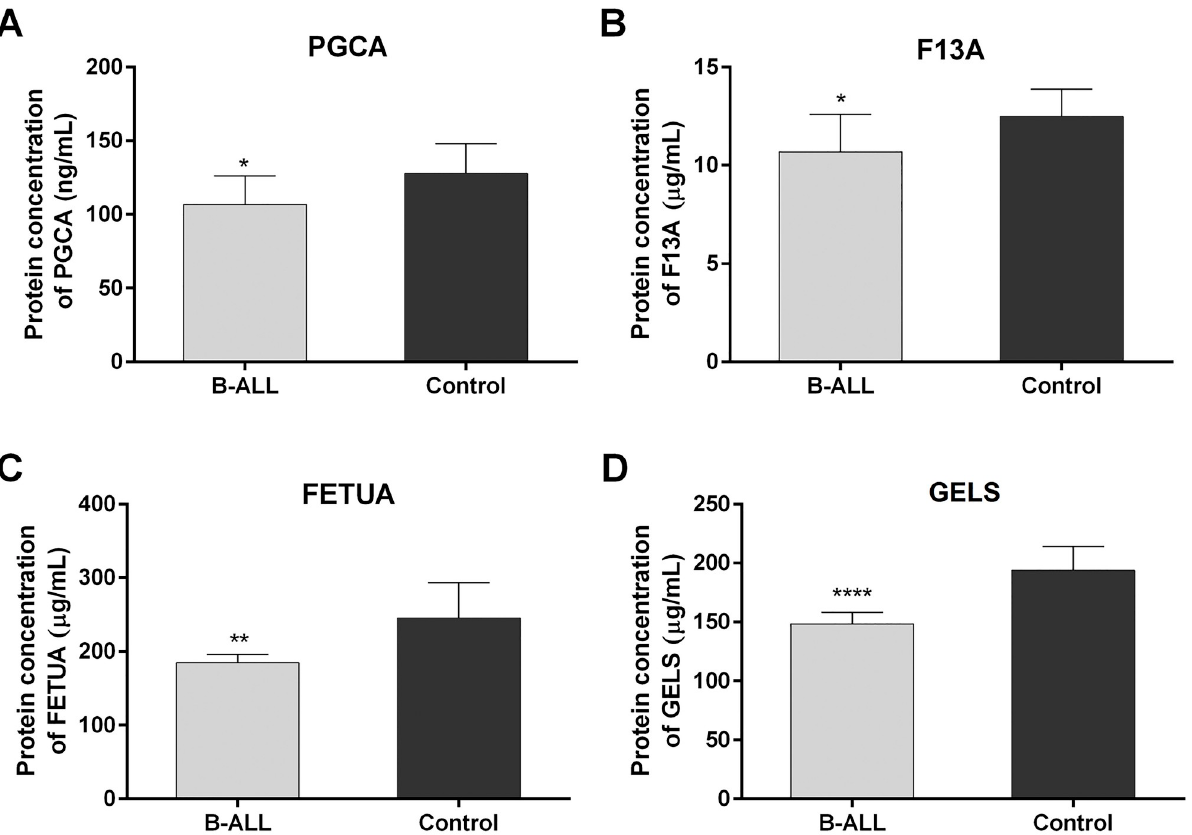
Fig 4. Plasma levels of PGCA, FETUA, F13A, and GELS. Plasma levels of PGCA (A), FETUA (B), F13A (C) and GELS (D) was detected by ELISA in B-ALL patients (n = 10) and control groups (n = 10). Statistical significance was determined by two-tailed non-paired Student’s t-test. Data as mean ± SEM. The analysis was performed using GraphPad Prism 7.0 �� P < 0.01 is significant, ���� P < 0.0001 is highly significant.